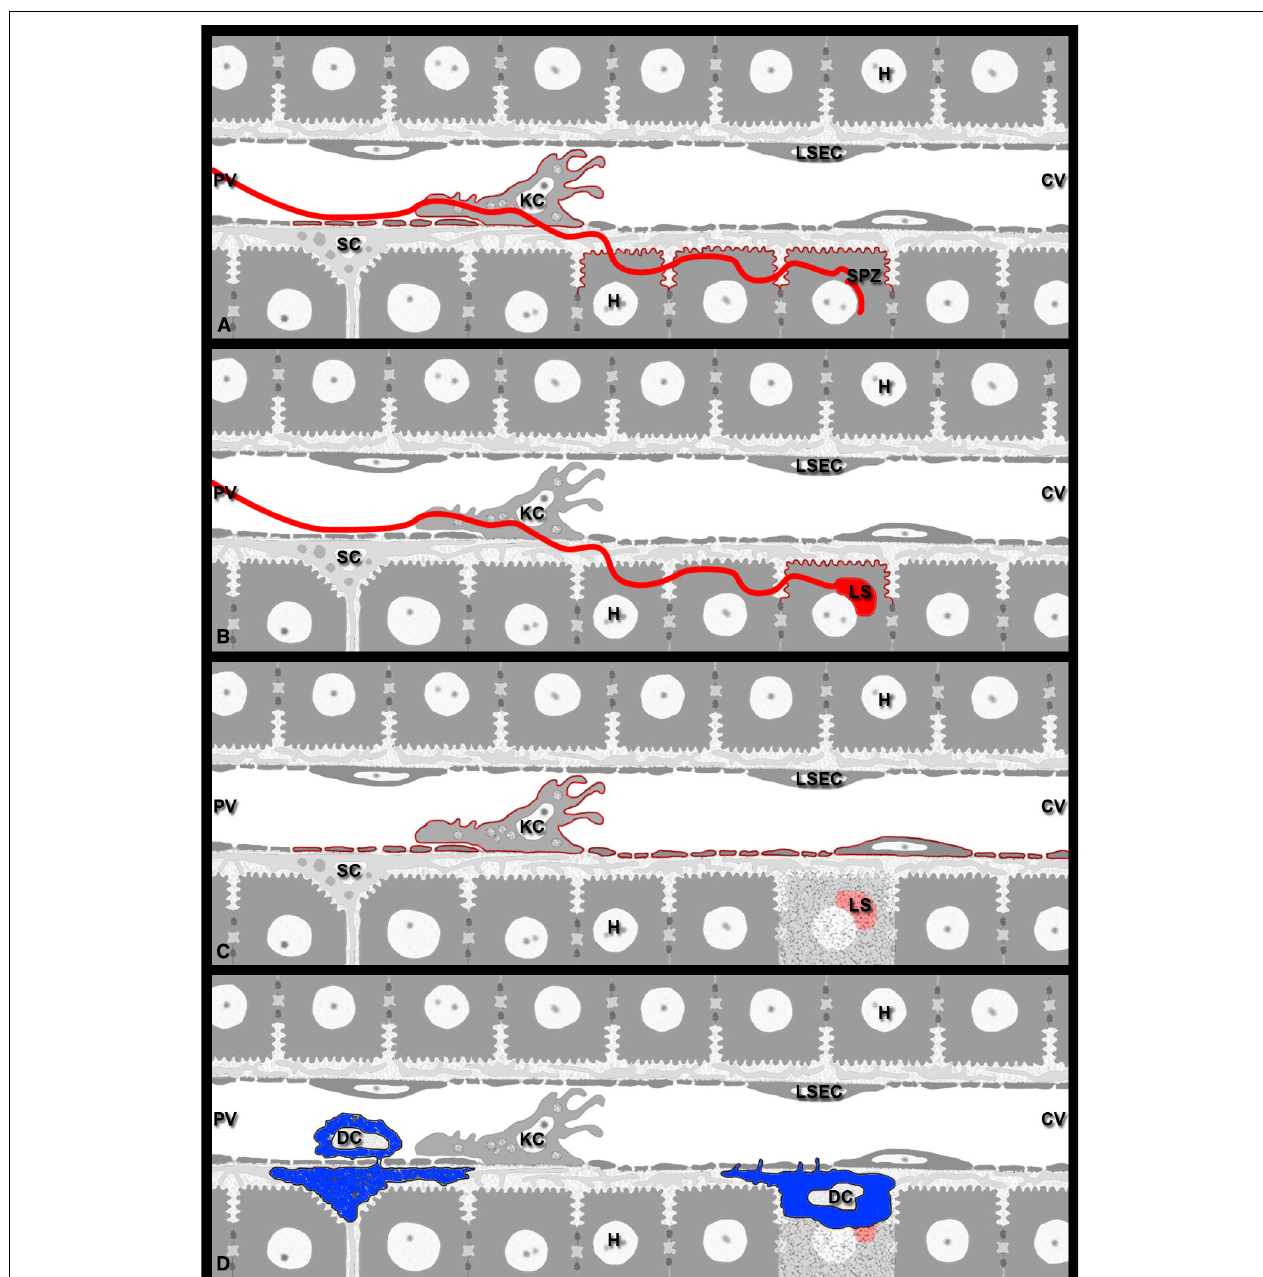
FIGURE 2 | Model for Plasmodium antigen presentation in the liver. (A) Sporozoites continuously release antigens such as CSP and TRAP from their surface. On their way from the sinusoidal lumen into the liver parenchyma, sporozoites glide along LSECs, traverse KCs, and migrate through several hepatocytes before infecting a final one (red line). In naïve mice, contact-mediated translocation of sporozoite antigens into the cytoplasm of these liver cells may result in antigen presentation by LSECs, KCs, as well as traversed and infected hepatocytes (red outline). (B) Sporozoite infection of naïve mice should allow late-LS antigen expression exclusively on infected hepatocytes, i.e., those cells in which the parasites develop (red outline). (C) During repeated exposure to viable sporozoites or multiple rounds of immunization with attenuated parasites, infected hepatocytes die after completion of LS development, resulting in the release of debris and leftover